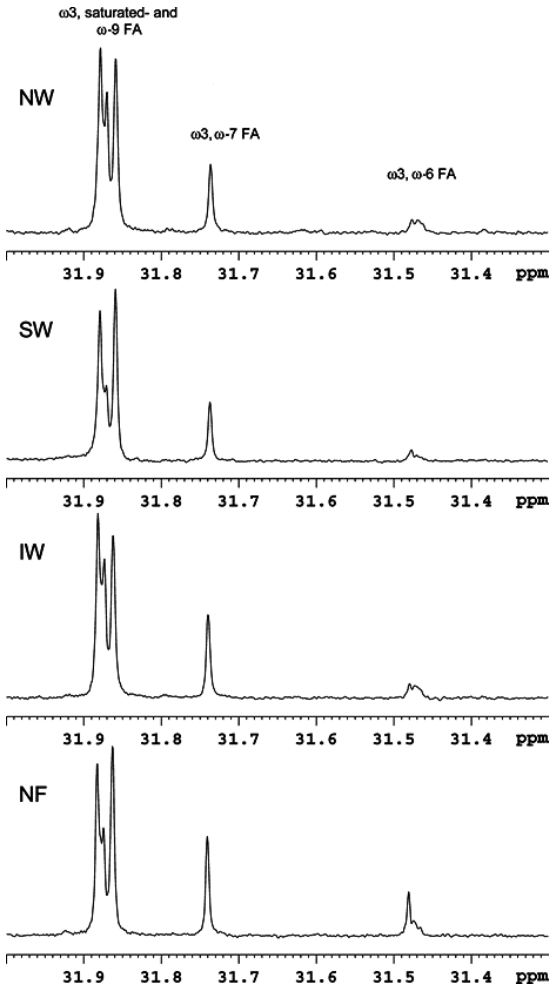
Figure 38. 13 C-NMR aliphatic region (32.0–31.3 ppm) of lipids extracted from salmon of four different origins: (from top) wild salmon from Norway (NW), Scotland (SW), and Ireland (IW) and farmed salmon from Norway (NF). Adopted, with permission, from [193]. Copyright 2009, American Chemical Society.